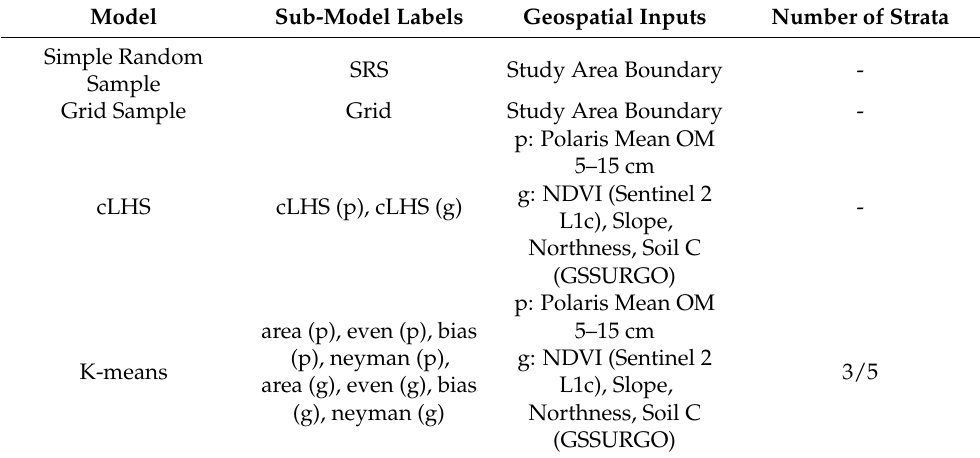
Figure 2. Sampling inputs at Oak Spring Garden. ( A ) all samples on the study site, ( B ) SRS at intensity of the power analysis ( n = 58), ( C ) Grid at power analysis results intensity, ( D ) Northness (yellow, closer to north, blue, closer to south), ( E ) Slope (yellow is steeper, min: 0, max: 17.3), ( F ) NDVI (yellow is higher NDVI, min: 0.22, max: 0.81), ( G ) Stratified geospatial from ( D – F ), ( H ) Interpolated mean carbon from measured TC using Empirical Bayesian Kriging (EBK) (yellow is higher, min: 0.79, max: 2.71), ( I ) Polaris mean OM (yellow is higher, min: 0, max: 2.77), ( J ) K-means Stratified from I. Table 1. Information about modeling approaches including inputs to stratification and